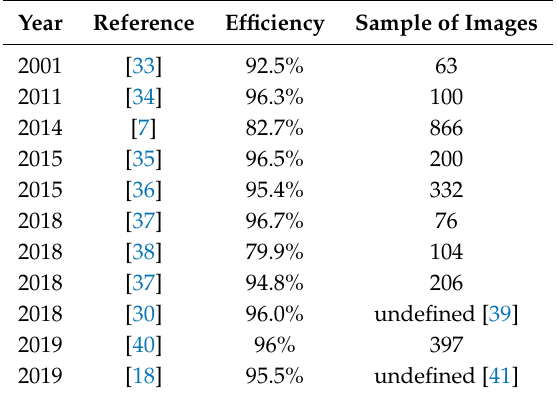
Table 1. Relevant research in the detection of melanoma using dermatological